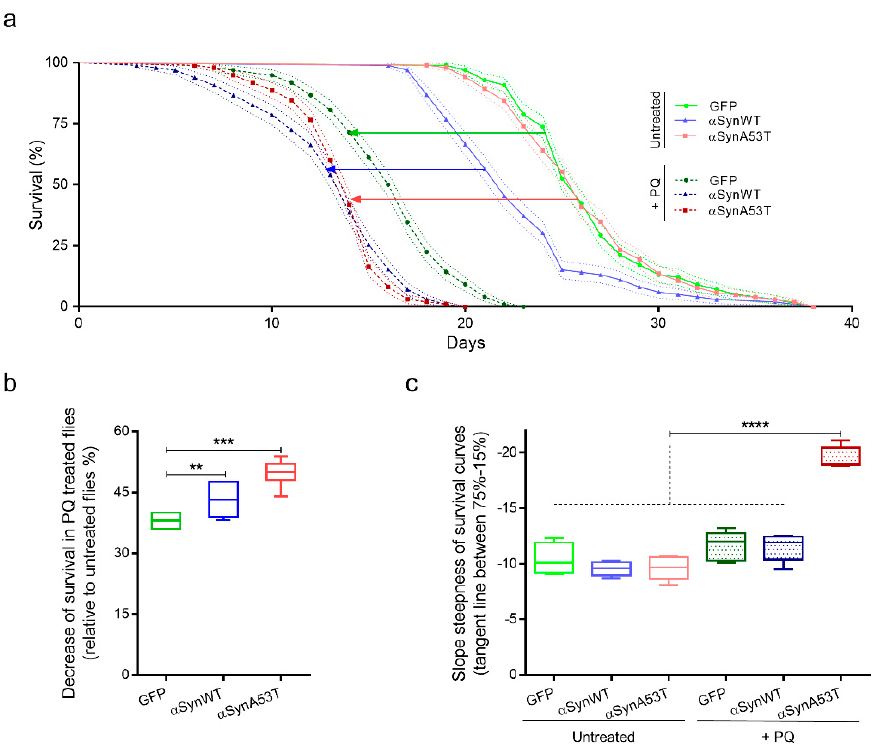
Figure 4. Chronic exposure to PQ induces a synergic toxicity with α Syn on transgenic Drosophila . ( a ) Survival curves of Drosophila males raised in control medium (agarose + 10% sucrose diet), ex- pressing GFP (light green), α synWT (light blue), α synA53T (light red) or raised in control medium supplemented with PQ (0.75 mM), expressing GFP (darker green), α synWT (darker blue), and α synA53T (darker red). Standard errors are represented for each survival curve as dashed light lines, n = 5 independent experiments for a total of 6861 flies. ( b ) Decrease of fly survival after PQ exposure. Statistical significance of differences (Mann–Whitney U-test) compared with GFP group, *** p = 0.0002 and ** p = 0.0087 respectively, n = 8. ( c ) Slope steepness of survival curves calculated between 75% and 15%. Statistical analysis was performed using Dunnett’s test for multiple compar- isons to evaluate intergroup differences, **** p < 0.0001, n = 5. In the box and whisker plots in ( b , c ), boxes extend from the first to the third quartile, the line inside the boxes shows the median and the whiskers represent the min/max value of independent experiments.